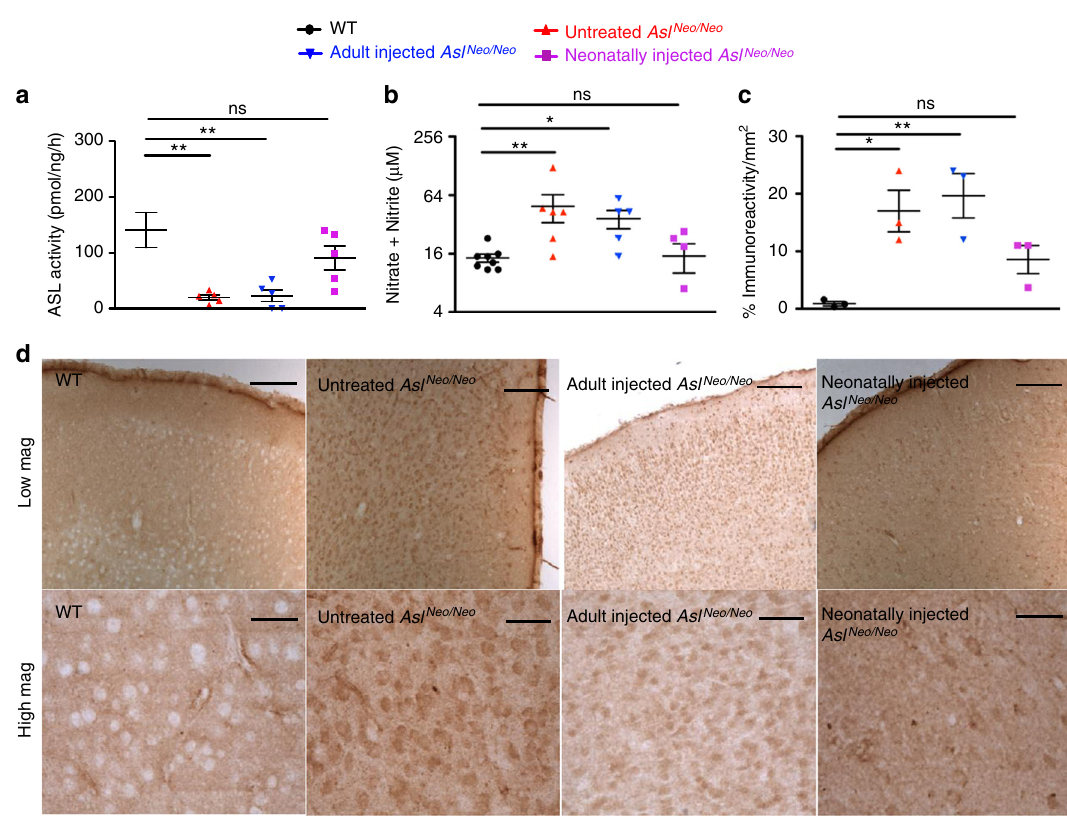
Fig. 5 Systemic neonatal but not adult injections of AAV8.EFS. mAsl exhibited long-term correction of the impaired NO metabolism in the brain. a Cortical argininosuccinate lyase (ASL) activity. b Levels of nitrite/nitrate levels in brain homogenates. c Computational quanti fi cation of nitrotyrosine immunostaining. d Representative images of nitrotyrosine-stained sections of cortex in WT, untreated, adult-injected and neonatally injected Asl Neo/Neo mice ( n = 3). Horizontal lines display the mean ± SEM. a − c One-way ANOVA with Dunnett ’ s post-test compared to WT: ns — not signi fi cant; * p < 0.05; ** p < 0.01. b Graph displays not transformed data. Statistical analysis used log-transformed data. WT n = 6 – 8 (littermates aged 9 or 13 months); untreated Asl Neo/Neo n = 5 – 6 (littermates aged 1 – 13 months as less than 10% of the animals had survived at the end of the study); adult-injected Asl Neo/Neo n =